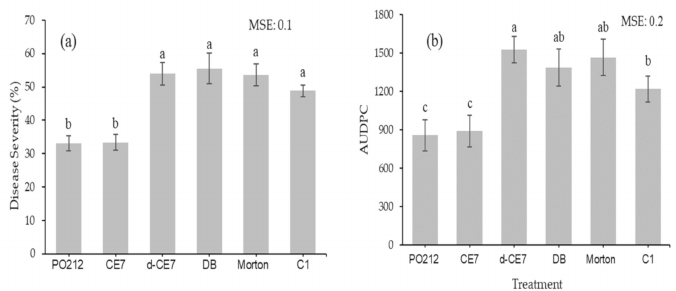
Figure 2. E ff ect of Penicillium rubens strain 212 (PO212) crude extract (CE7) after digestion with proteinase K (d-CE7) on the disease severity ( a ) and area under the disease progress curve (AUDPC) ( b ) caused by strain 1A of Fusarium oxysporum f.sp. lycopersici (FOL1A) in tomato plants at 29 days after transplanting and inoculation in growth chamber assay. CE7, PO212 CE after growing into Morton’s medium for 7 days; DB, Digestion bu ff er 5 × ; Morton, plants treated with Morton´s B medium; C1, control plants treated with sterilized distilled water and inoculated with FOL1A. See Table 1 for description of treatments. Data are mean value of two assays with ten replications (flasks) per treatment and four plants per replication. Data were subject to log 10 (x + 1) transformation to improve the homogeneity of variances before analysis. Means with the same letter in each parameter are not significantly di ff erent from each other ( p ≥ 0.05) according to the Student–Newman–Keuls multiple range test. Vertical bars represent the standard error of the mean of ten replications. MSE is mean squared error of analysis of